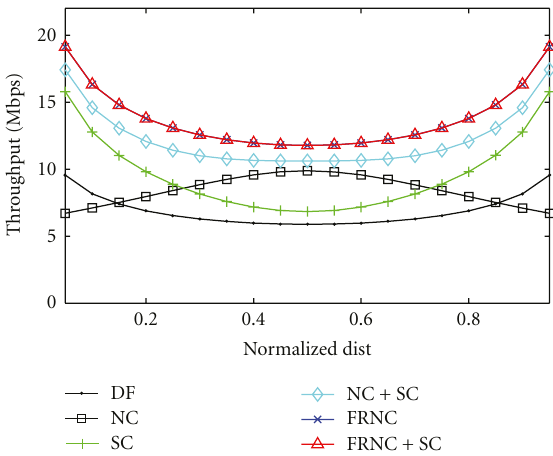
Figure 6: Throughput achieved by di ff erent schemes on the broad- cast channel-e ff ect of relay position for two way relay (theoretical calculation, no constellation size